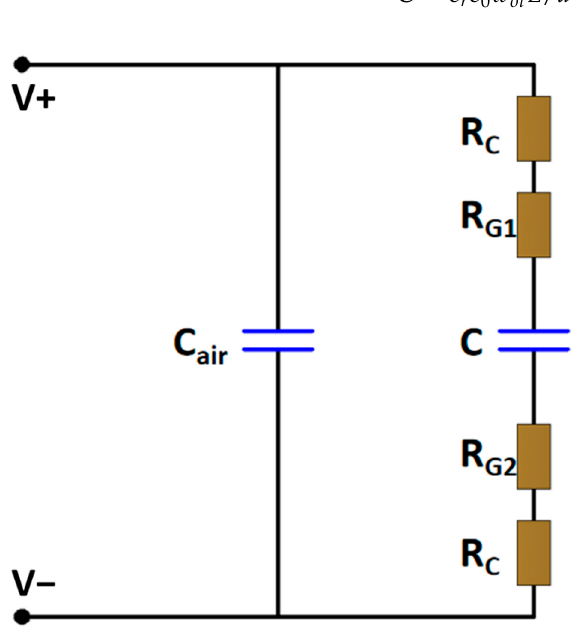
Figure 20. Equivalent circuit model for the estimation of